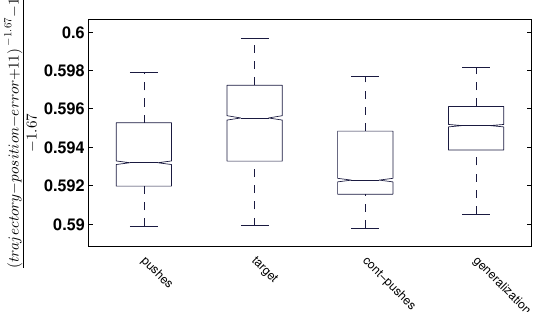
(a) The performance of the DMP1 model for each benchmark scenario is shown. It considers the performance over all shapes in the data-set.